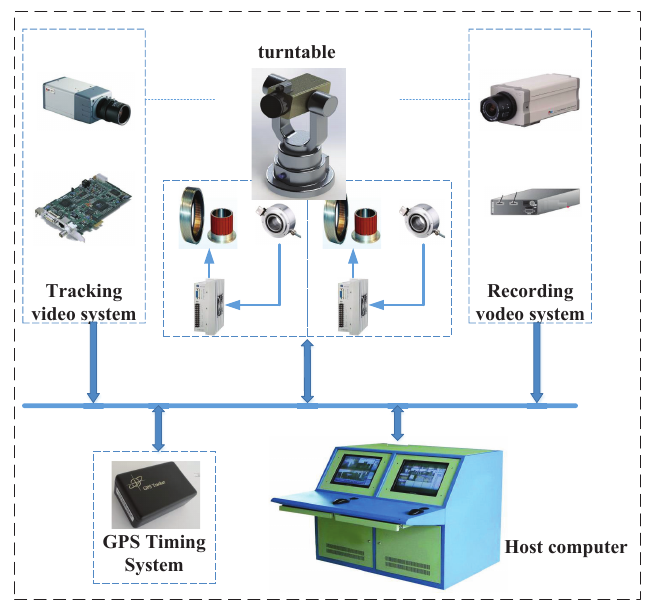
Figure 3. Turntable servo